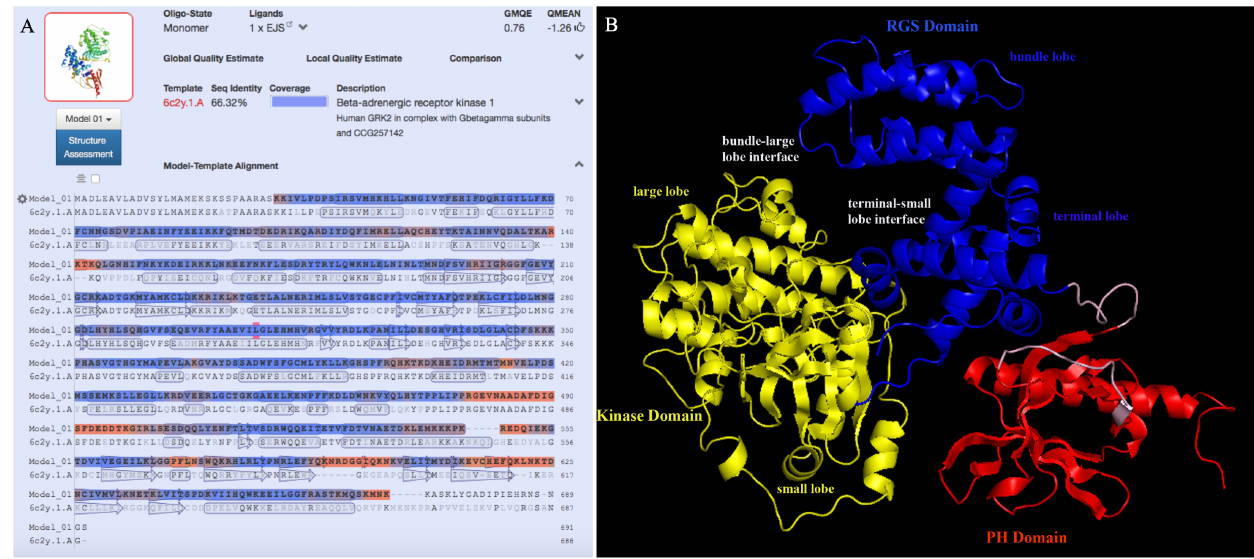
Figure 6. Homology modeling of the Ov-GRK1. ( A ) Alignment with a potential Model-Template (6c2y). ( B ) 3D structural view for the prediction of ligand binding sites in Ov-GRK1 generated by 3DLigandSite based on the